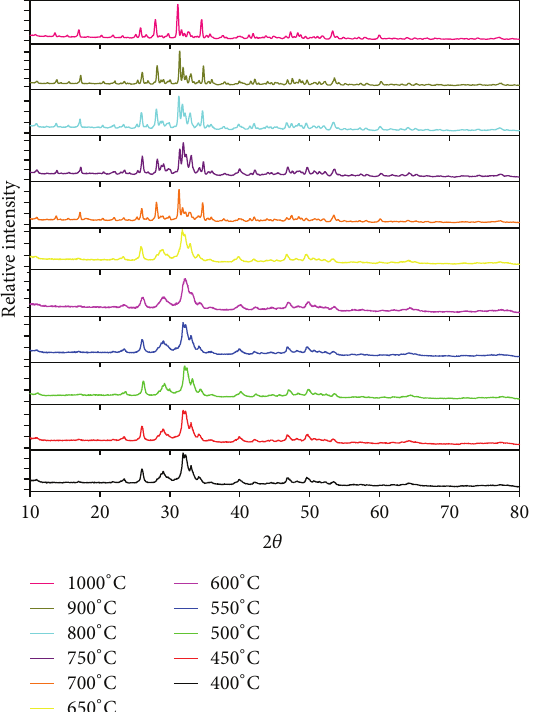
Figure 3: Diffraction patterns as a function of temperature sintering of hydroxyapatite.